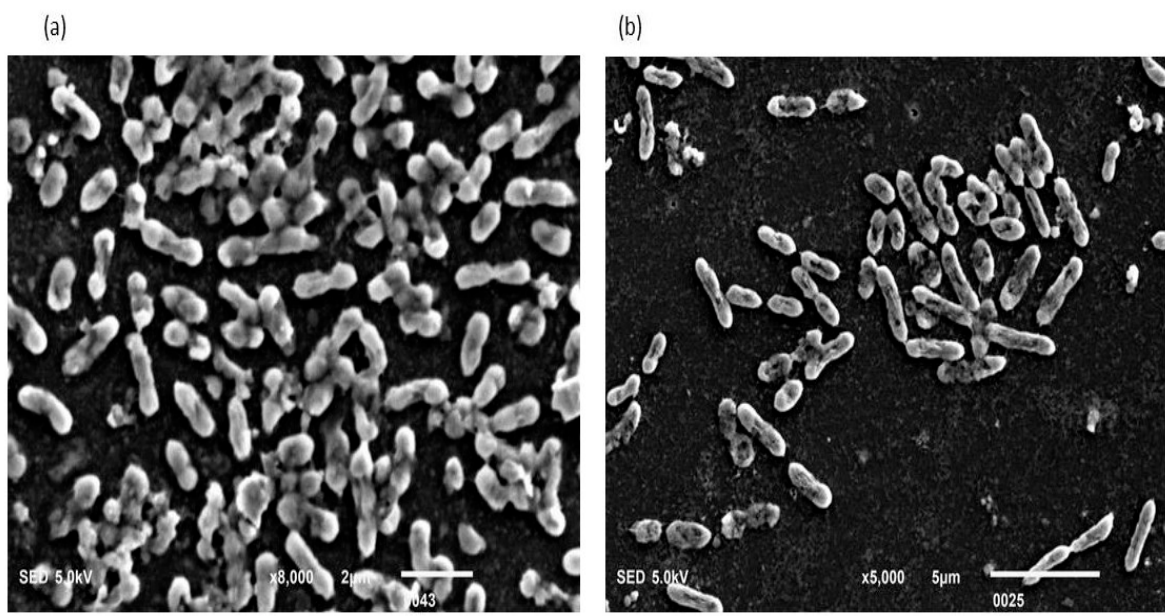
Figure 9. ( a , b ) The biofilm consortia were exposed to Triton X100 for 30 s. The picture depicted that the consortium was dispersed in 30 s, and the cells were killed and squeezed. The extracellular matrix material was wiped and nanotubes disappeared from the cell surface. The results indicated that Triton X100 was equally effective against biofilm consortia developed in between two slides under-weight pressure and against normal biofilms.